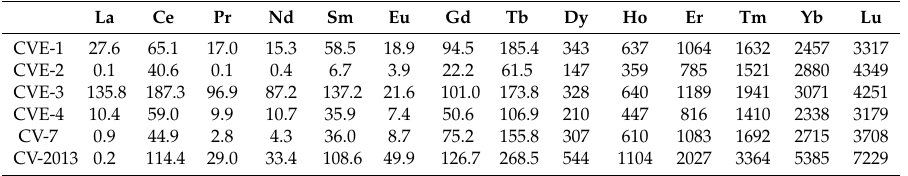
Table 3. Average rare earth element concentrations measured in zircon from rock samples of the Cheever Mine, New York. Concentrations are normalized to chondritic values